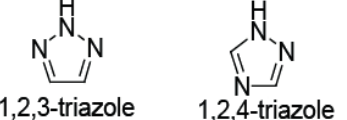
Figure 1 - Structure of isomeric Triazoles.